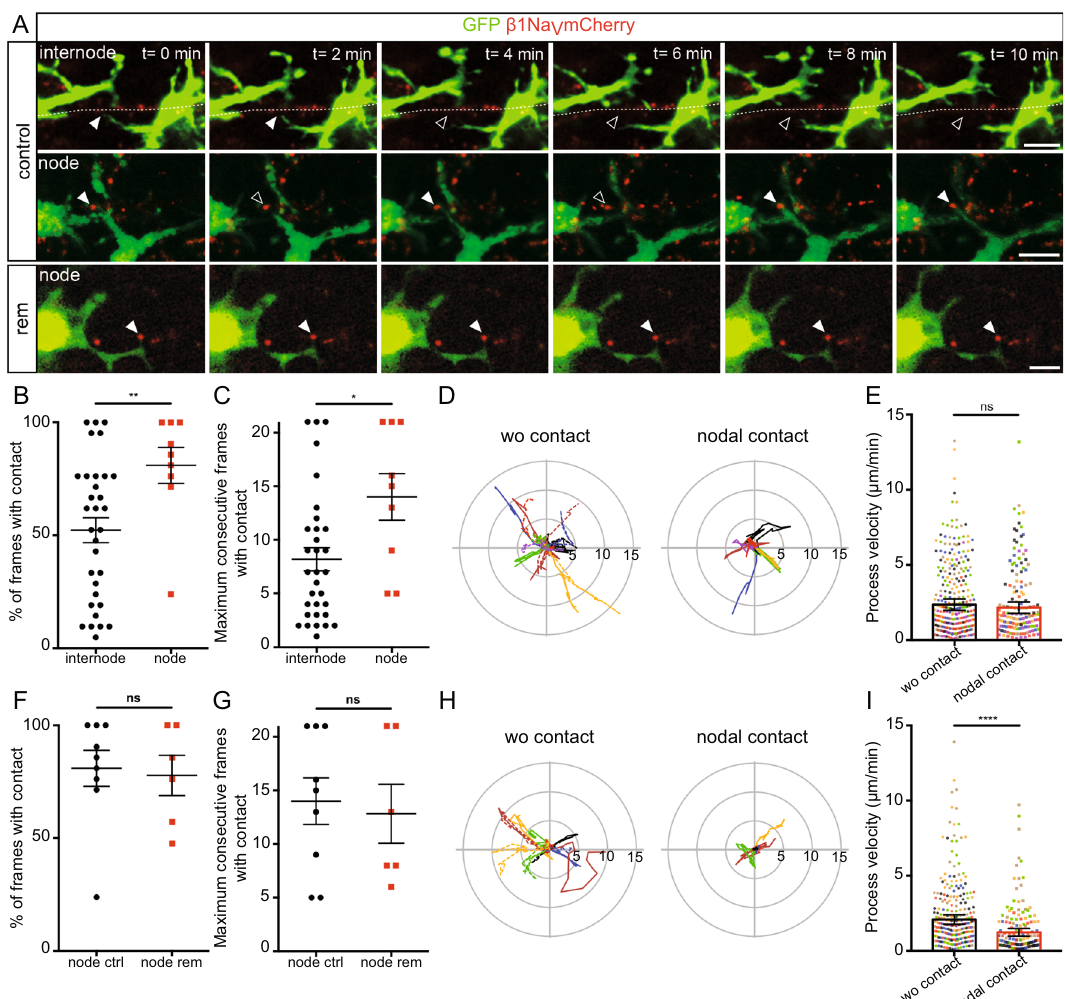
Fig. 4 Microglia process dynamics are modi fi ed by nodal structure vicinity in myelinated and remyelinating cultured slices. A Microglial cells (green) initially contacting an internode or a node (red) in myelinated slices (control), or a node in a remyelinating slice (rem). Arrowheads show the initial contact position ( fi lled: contact, empty: no contact). (control: internode: n = 32 contacts from 16 animals, node: n = 9 contacts from 8 animals; rem: n = 6 contacts from 6 animals). B , C Dynamics of microglial processes contacting an internode vs a node in myelinated slices (internode: n = 32 contacts from 16 animals, node: n = 9 contacts from 8 animals). D Trajectories (with t0 position as reference, distance in µ m) of microglial process tips in myelinated slices, initially contacting a node (nodal contact) or not (wo contact). wo contact: n = 14, nodal contact: n = 7, from 7 color coded animals. Type II Wald χ 2 (two-sided analysis), p = 1.679e-8 (for quanti fi cation, see Fig. S4F). E Instantaneous process velocity in myelinated slices. wo contact: 280 measures from 14 trajectories in 7 animals, nodal contact: 140 measures from 7 trajectories in 7 color coded animals. F , G Dynamics of microglial processes contacting a node in control (node ctrl) or remyelinating slices (node rem). ctrl: n = 9 contacts from 8 animals, rem: n = 6 contacts from 6 animals. H Trajectories (with t0 position as a reference, distance in µ m) of microglial process tips in remyelinating slices, initially contacting a node or not. wo contact: n = 12, nodal contact: n = 6, in 6 color coded animals. Type II Wald χ 2 test (two-sided analysis), p = 2.2e-16 (for quanti fi cation, see Fig. S4H). I Instantaneous process velocity in remyelinating slices. wo contact: 240 measures from 12 trajectories in 6 animals, nodal contact: 120 measures from 6 trajectories in 6 color coded animals. Scale bars: A 10 µ m. B , C , F , G Two-sided Mann – Whitney test, E , I Type II Wald χ 2 test (two-sided analysis). * P < 0.05, ** P <